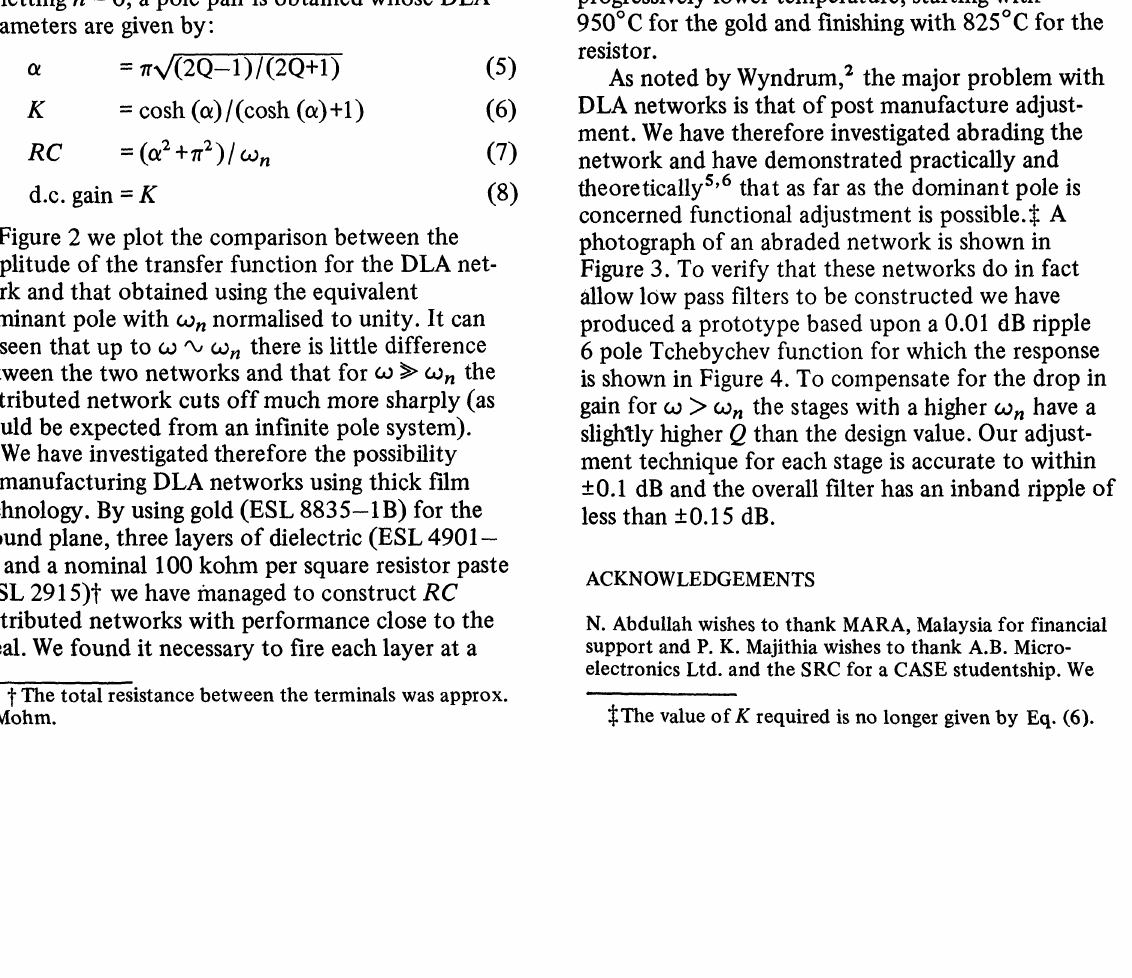
FIGURE 4 Measured response of a cascade of three D.L.A. networks adjusted to approximate to a 0.01 dB 6 pole Tchebychev